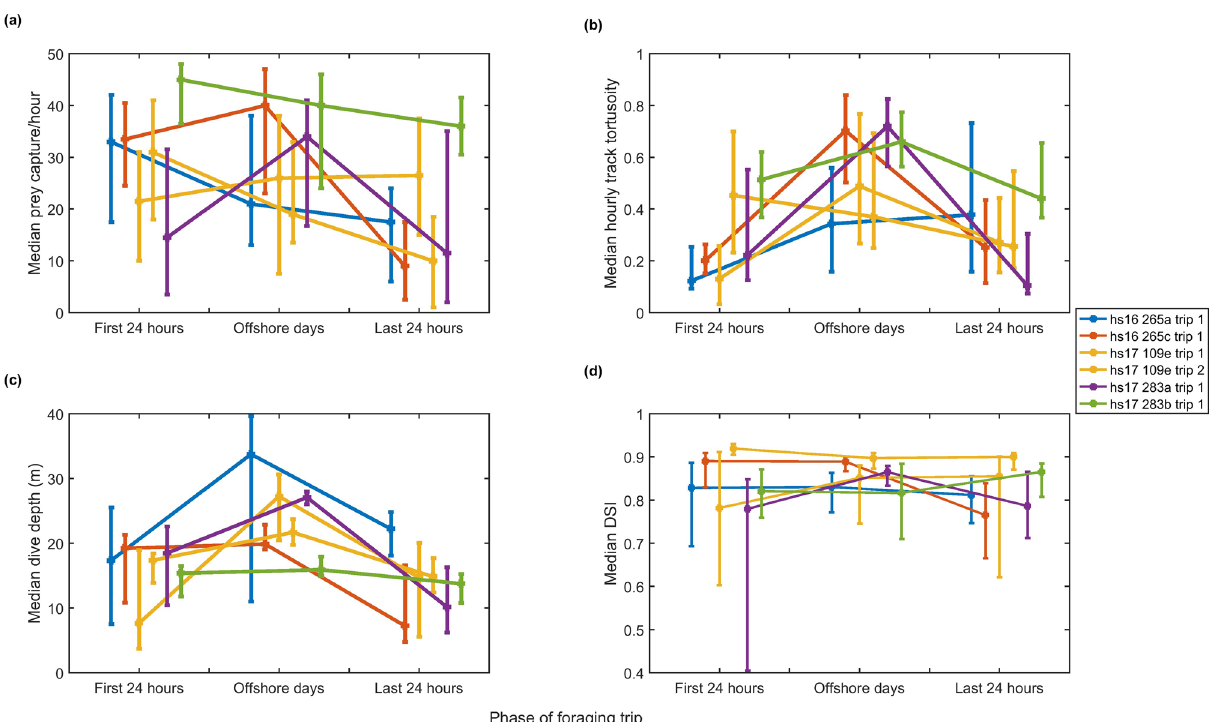
Figure 2. Median of ( a ) hourly PCA count, ( b ) hourly track tortuosity; ( c ) dive depth and ( d ) dive shape index (DSI) over the three phases of each foraging trip, with error bars representing upper and lower quartiles. ‘First 24 h’ encompasses the trip offshore from the haul-out. ‘Last 24 h’ encompasses the return trip to shore. ‘Offshore days’ encompasses all times in between. Colours represent individual foraging trips and six complete trips from five individuals are